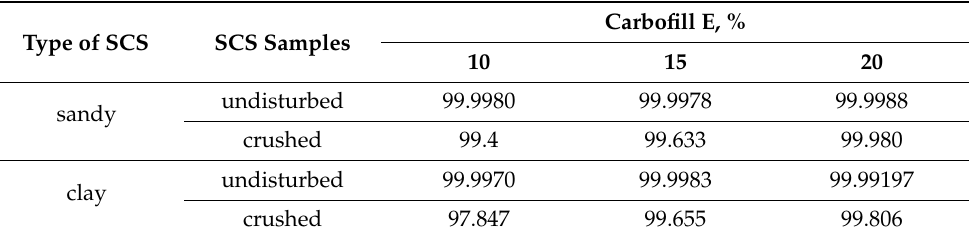
Table 4. Dependence of the efficiency of immobilization of Cr (VI) as a percentage of the SCS type and the amount of Carbofill E. Carbofill E, % Type of SCS SCS Samples 10 15 20 undisturbed 99.9980 99.9978 99.9988 sandy crushed 99.4 99.633 99.980 undisturbed 99.9970 99.9983 clay crushed 97.847